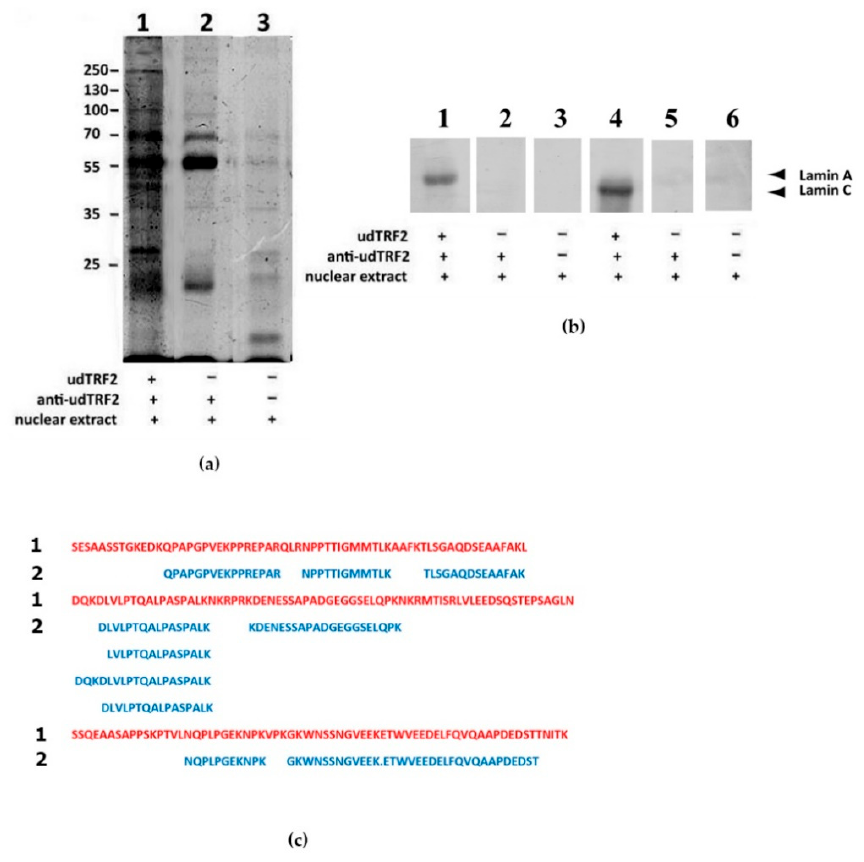
Figure 4. ( a ) Co-immunoprecipitation (12% SDS-PAGE, CBB). Lane 1, A Sepharose beads from a column loaded with udTRF2 AB, udTRF2, and nuclear extract (experiment); lane 2, column loaded with anti-udTRF2 AB only and nuclear extract (negative control 1); lane 3, A Sepharose beads from the column loaded with nuclear extract without AB (negative control 2). Mr of marker indicated on the left. ( b ) Western blot of A Sepharose columns. Lanes 1 and 4, A Sepharose beads from the column loaded with udTRF2 AB, udTRF2, and nuclear extract (experiment); lanes 2 and 5, column loaded with anti-udTRF2 AB only and nuclear extract (negative control 1); lanes 3 and 6, A Sepharose beads from the column loaded with nuclear extract without AB (negative control 2). Identical strips probed by lamin A and C AB in the upper row. Lamin positions are marked by arrows. Data are representative of three independent experiments using two independent nuclear extracts; ( c ) 1, udTRF2 sequence (red); 2, the peptide sequences found in LC–MALDI spectra (blue). All peptides defined as TRF2 belong only to the udTRF2 region.